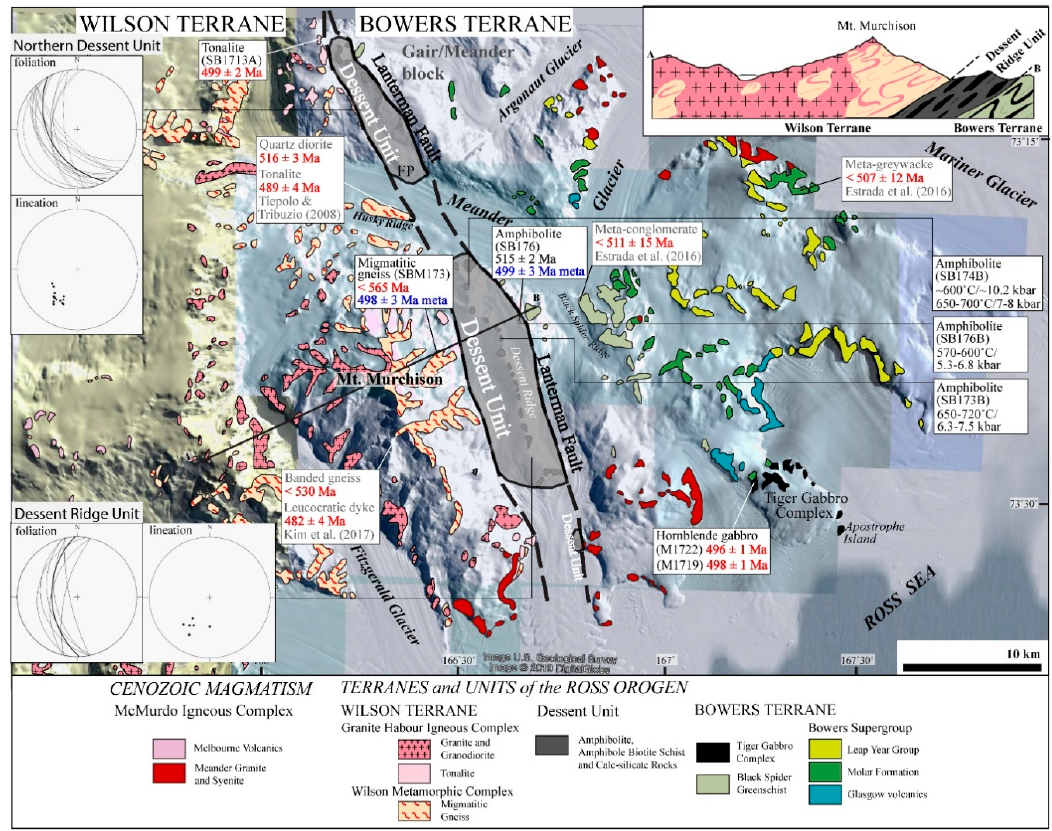
Figure 2. Geological map of the Mountaineer Range (modified after Capponi et al. [43,44]) with zircon U–Pb ages. The profile (A–B) structure crosscutting Mt. Murchison was adopted and modified from Capponi et al. [43,44]. The Mountaineer Range is located in the WT / BT boundary region and includes Mt. Murchison (WT), the Tonalite Belt (WT), the Dessent Unit, the Black Spider Greenschist (BT), the Tiger Gabbro Complex (TGC) and the Bowers Supergroup (BT). The Lanterman Fault zone borders the WT and the BT. Structural measurements (mylonitic foliation and mineral stretching lineation) and metamorphic P (pressure)–T (temperature) conditions of the Dessent Unit are presented. For the zircon U–Pb ages, igneous and protolith ages are marked in red and metamorphic ages in blue. Literature zircon U–Pb data include those of Estrada et al. [39], Kim et al. [48] and Tiepolo and Tribuzio [65]. FP, Frank